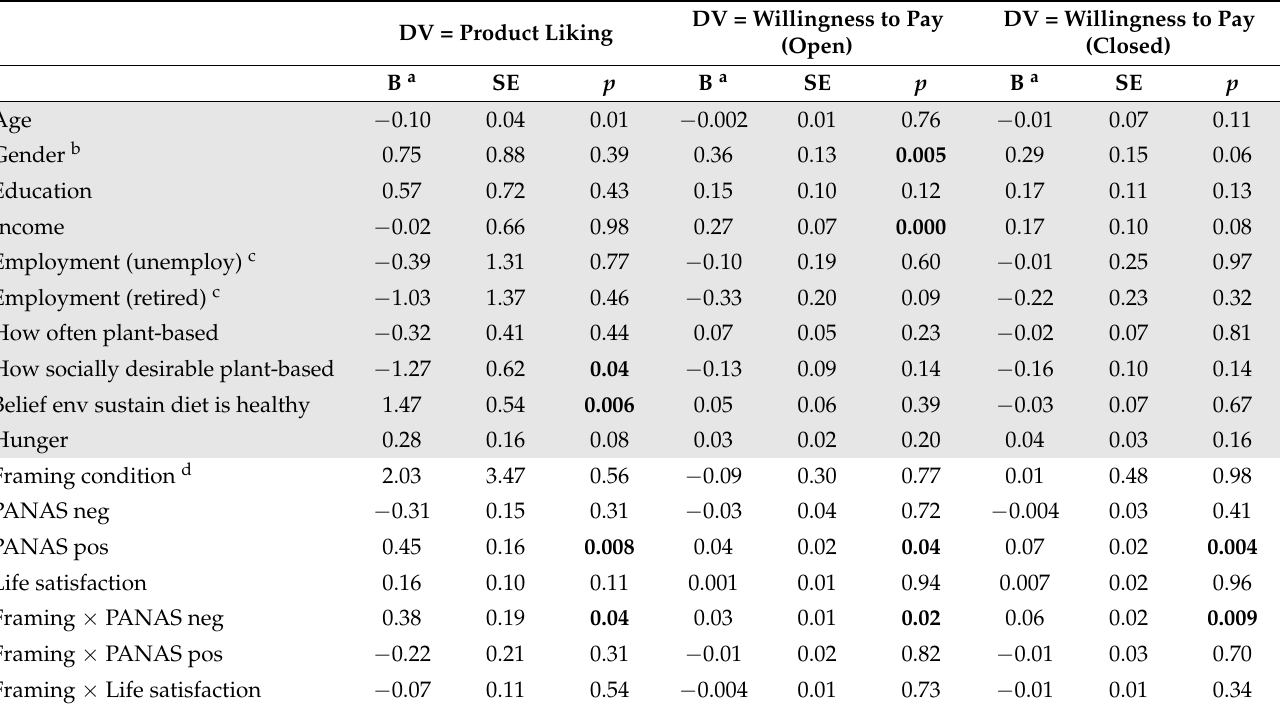
Table 3. Predictors of participants’ levels of product Liking and willingness to pay in Study